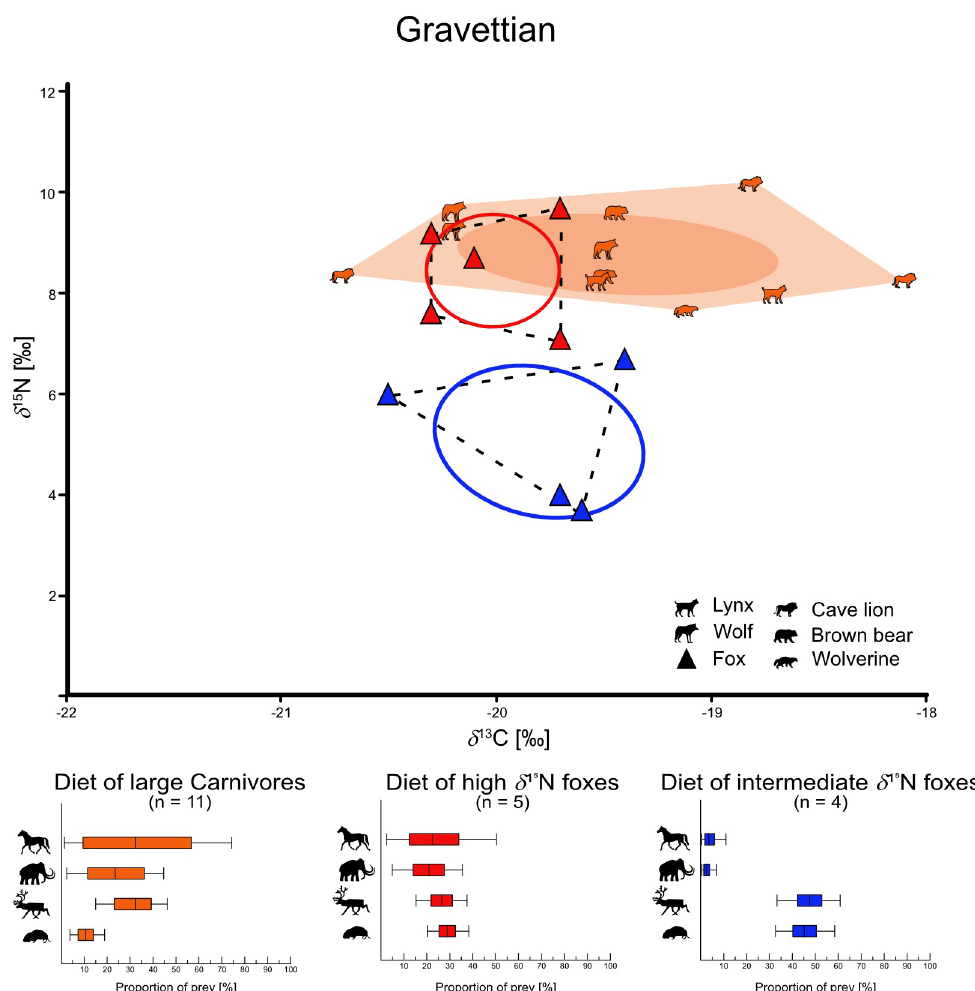
Fig 5. Trophic niches in the Aurignacian. Calculated trophic niches of foxes (Triangles) and large carnivores (shapes) from the Gravettian with SIBER. Dashed lines in the fox niches as well as light collard area in the large carnivore group show the convex hull (outline of the niches). The solid lines in the fox niches and the dark collard ellipses in the carnivore group show the calculated Standard Ellipse Area (SEA) and reflect the core niches, based on Bayesian statistics. In the lower part of the figure is the reconstructed diet given. Diet proportions calculated with MixSIAR of each fox niche and the large carnivore group. Solid lines show the 5 to 95% confidence interval, full boxes show the 25 to 75% confidence interval and vertical black line shows the median